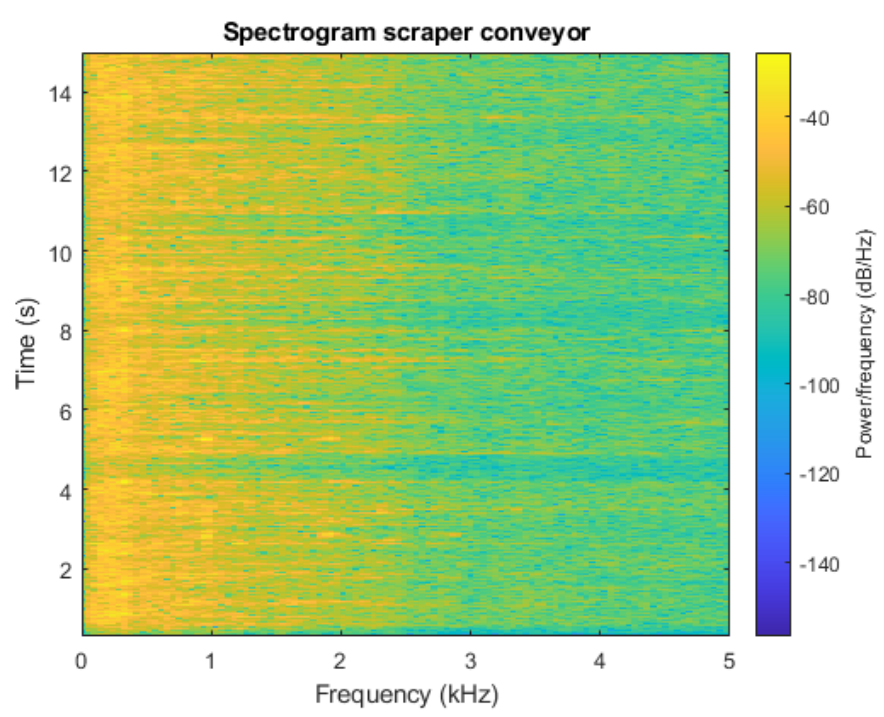
Figure 4. Spectrogram STFT for the scraper conveyor.